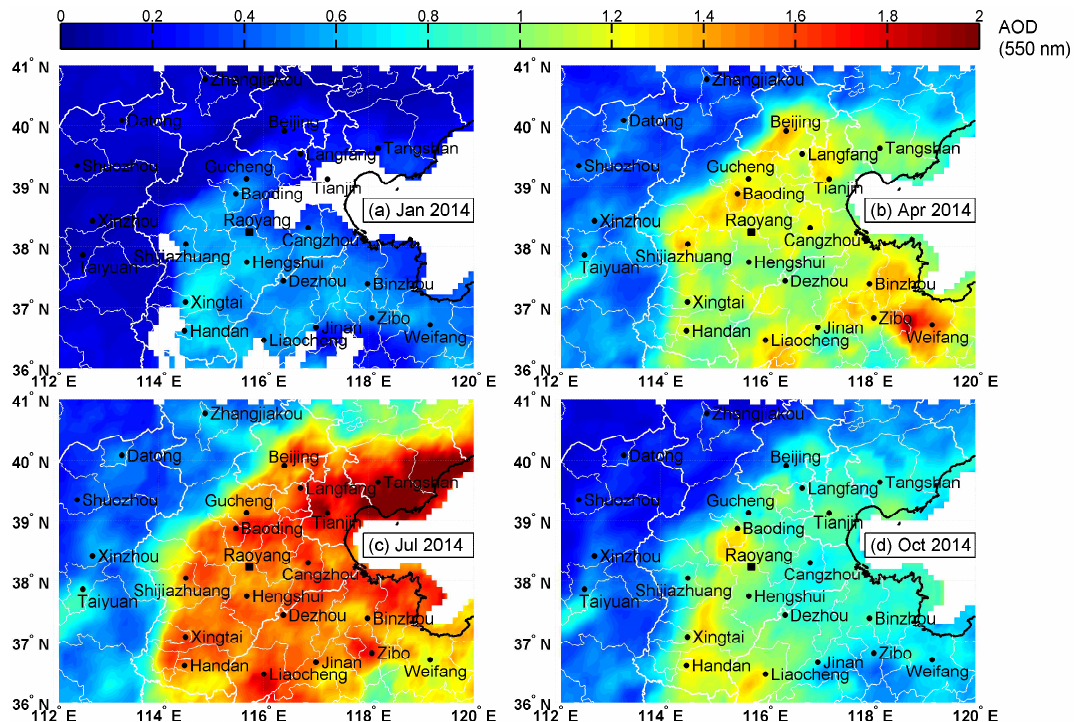
Figure 1. The spatial distribution of averaged MODIS aerosol optical depth (AOD) at 550nm in (a) January; (b) April; (c) July; (d) October 2014 in the NCP. The locations of the semirural site Raoyang and major cities are respectively marked by a square and dots. Only grids with the fraction of valid data exceeding 30% in the month are